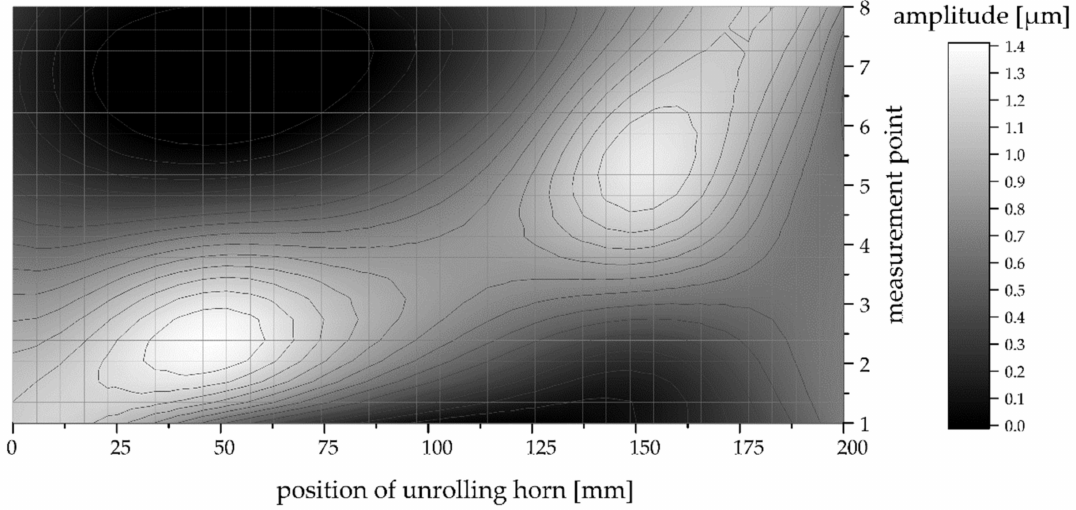
Figure 3. Development of oscillation amplitude depending on the current position of the